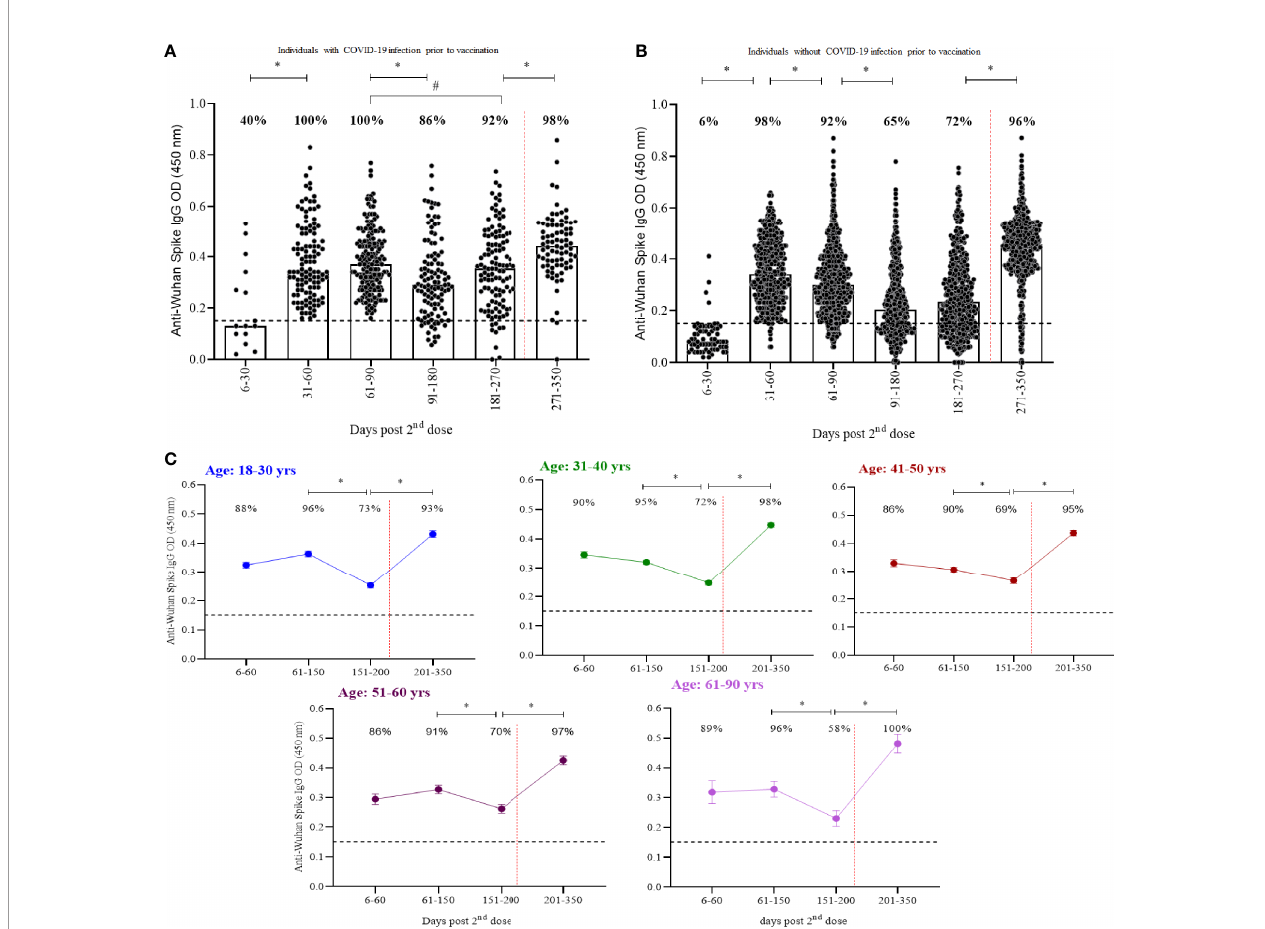
FIGURE 2 | Kinetics of anti-spike IgG over a one-year period separated by (A) participants with COVID-19 infection prior to vaccination, (B) participants without COVID-19 and (C) age groups. Median OD of anti-spike IgG, measured by ELISA, is represented by bars, percentage values indicate seropositivity rate. Limit of detection of 0.1508 is represented by the black lines. Dotted red lines represent booster dose timepoint. Mann- Whitney and ANOVA statistical differences are presented by letters for comparisons over time points within the same groups (*) and between individuals with and without prior COVID-19 in the same time period (p < 0.0001)